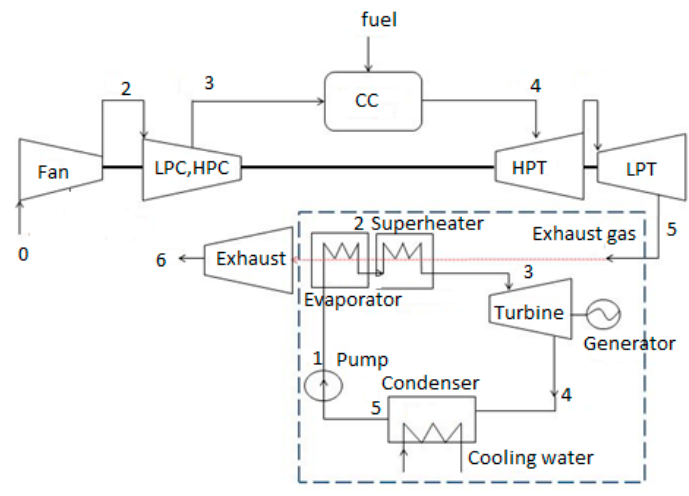
Figure 7. Schematic diagram for case B and case D [35].